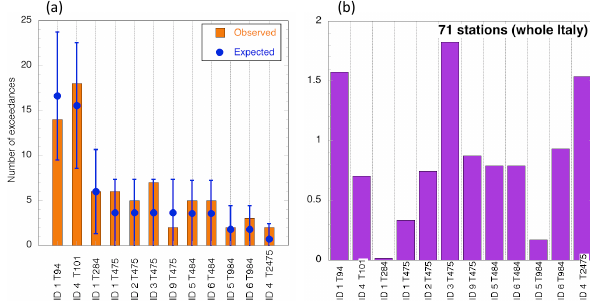
Figure 7. Results of scoring for national-based PSHA models. (a) Observed versus computed number of stations exceeding the pre- dicted PGA values g 0 . Results are sorted according to the return period and subordinately on model IDs. (b) Final scores: the y -axis represents the absolute value of Z score as given in Eq. (3); the lower the best. Model IDs are given in Table 1; Tyear indicates the mean return time the elaboration refers